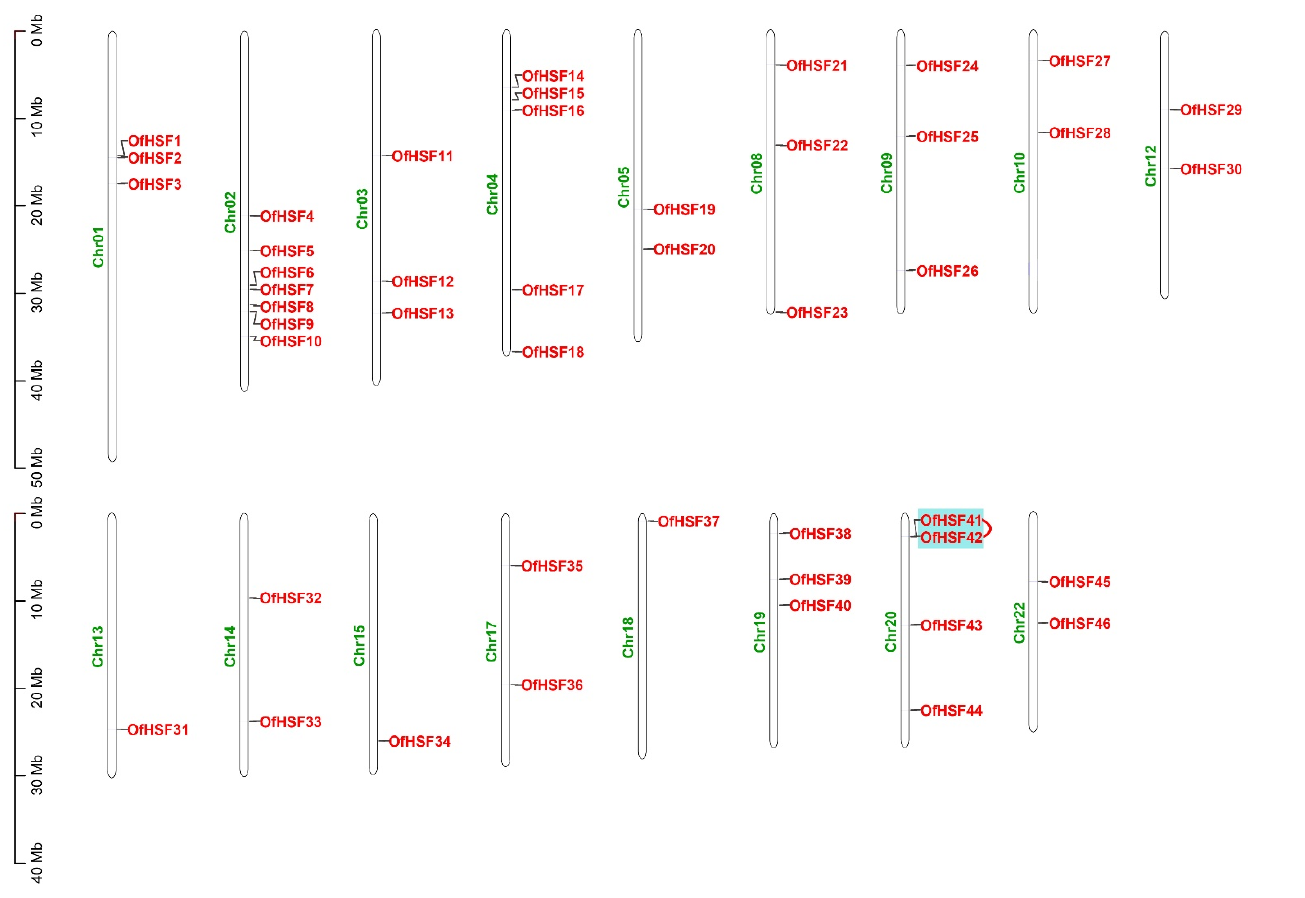
Figure 4. Distribution of OfHSF s on the chromosomes of O. fragrans . The scale on the left side of the picture is in million bases (Mb). The chromosomal numbers are shown to the left of each chromosome. The blue rectangle represents the tandem duplication.